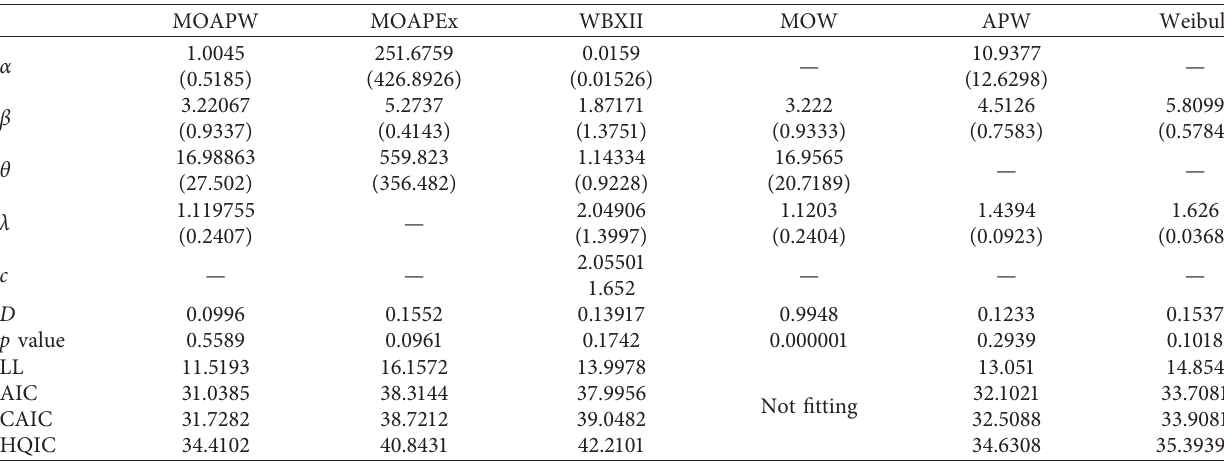
Table 7: MLE, St. E, K-S distance, p values, and different criteria for the second data